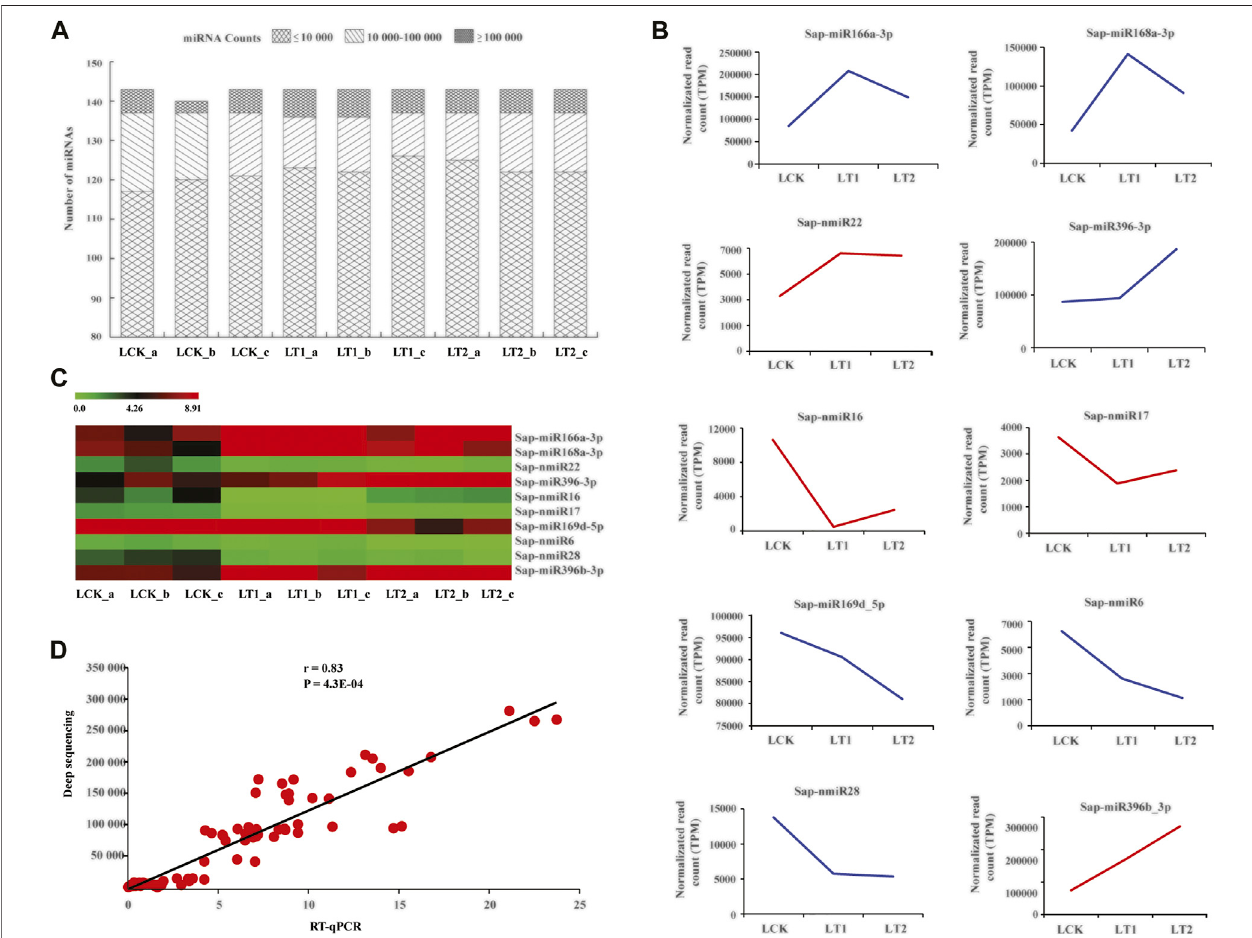
FIGURE 4 | Abundance characteristics of miRNAs obtained from S. apetala samples subjected to deep sequencing. (A) A global view of miRNA accumulation levels. (B) Representative graphs of accumulation pro fi le for 10 most abundant miRNAs. These miRNAs were divided into six categories on the basis of their accumulation patterns, which were distinguished by the colors of lines. (C) Relative transcript abundance of the 10 most highly accumulated miRNAs with the help of real-timequantitativepolymerase chainreaction (RT-qPCR)incontrol(LCK), 1 day (LT1)and 28 days (LT2)salinity treatment of S.apetala .a,band crepresentthe three biological repetitions for each treatment. (D) Pearson correlation coef fi cient ( r ) analysis between accumulation levels by RT-qPCR and deep sequencing for the 10 most abundant miRNAs.